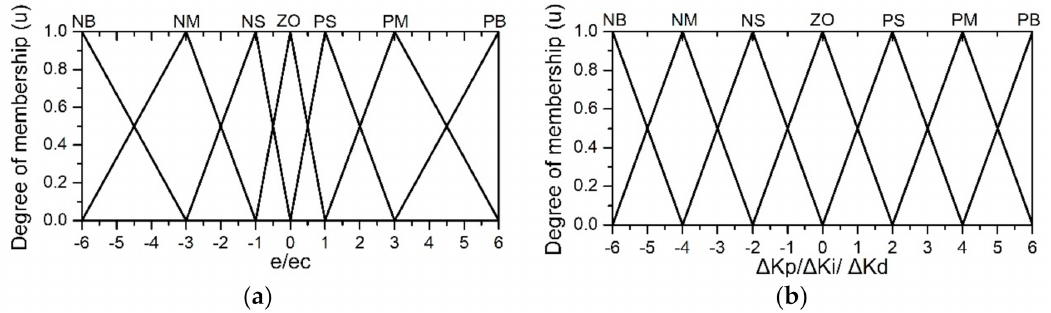
Figure 11. The membership functions: ( a ) Input variables e , ec ; ( b ) Output variables ∆ K p , ∆ K i , ∆ K d .